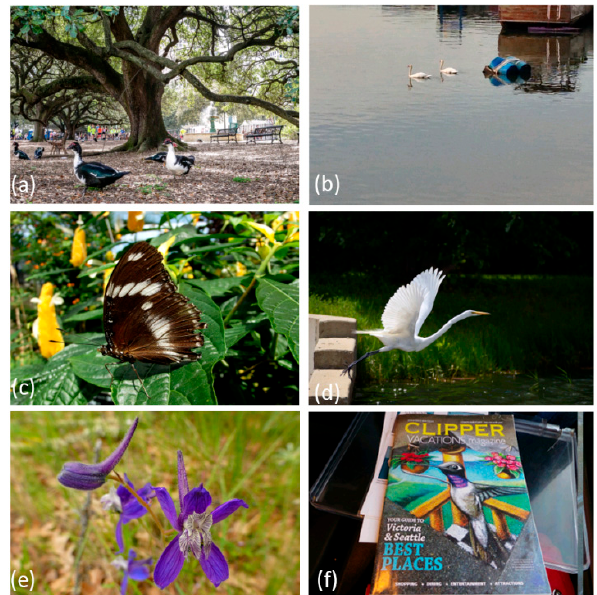
Figure 4. Only YOLO detected bird photographs.